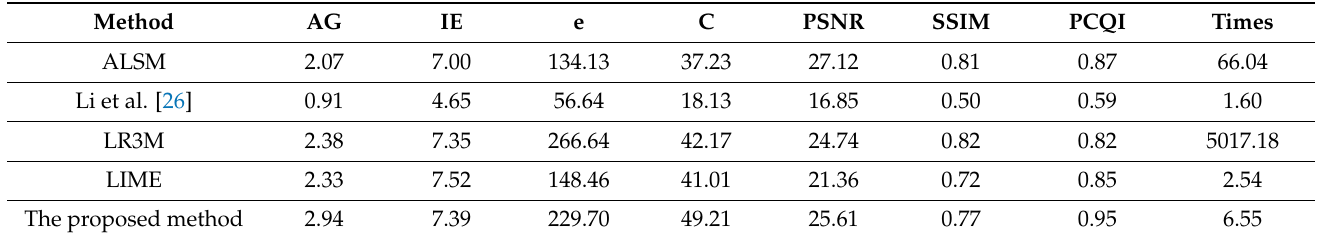
Table 2. Comparison of various indexes of multi-exposure data 1 enhanced by different